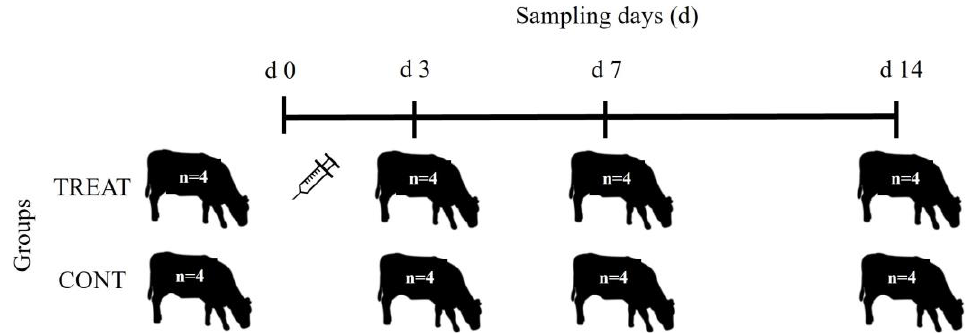
Figure 6. Experimental design and timeline for fecal sampling. TREAT: treatment group that received a single intramuscular injection of 1 mL of oxytetracycline hydrochloride (200 mg) and sodium diclofenac (5 mg) suspension (Oximic Plus LA, Microsules, Uruguay) per 10 kg body weight on day 0.